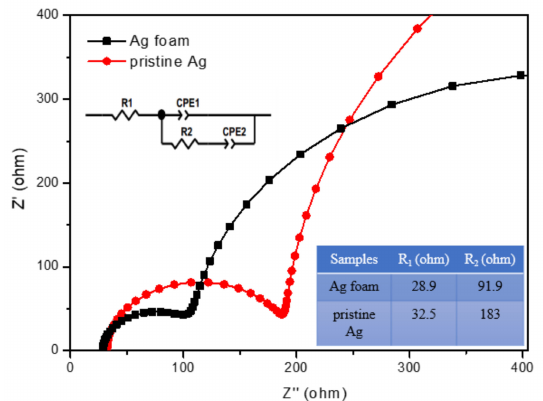
Figure 4. The Nyquist diagrams obtained for Ag foam and pristine Ag. The inset is the equivalent electrical circuit used to fit the EIS data (R 1 denotes the uncompensated electrolyte resistance, CPE1 is the double-layer capacitance at the electrode-electrolyte interface, R 2 is the charge transfer resistance and CPE2 denotes the Warburg-type impedance arising from the diffusion of redox-active species to the electrode interface). Experimental conditions: anolyte, 0.5 M NaOH; catholyte, CO 2 -saturated 0.1 M KHCO 3 ; 25 ◦